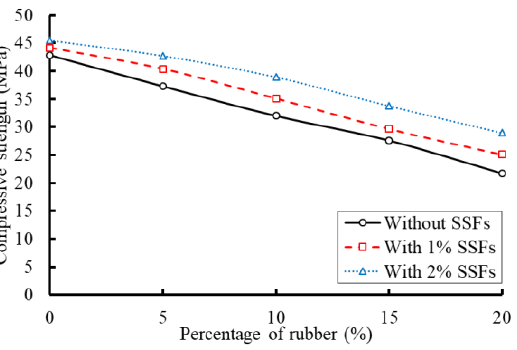
Figure 16. Effect of the SSF percentage on the compressive strength of concrete with CR.